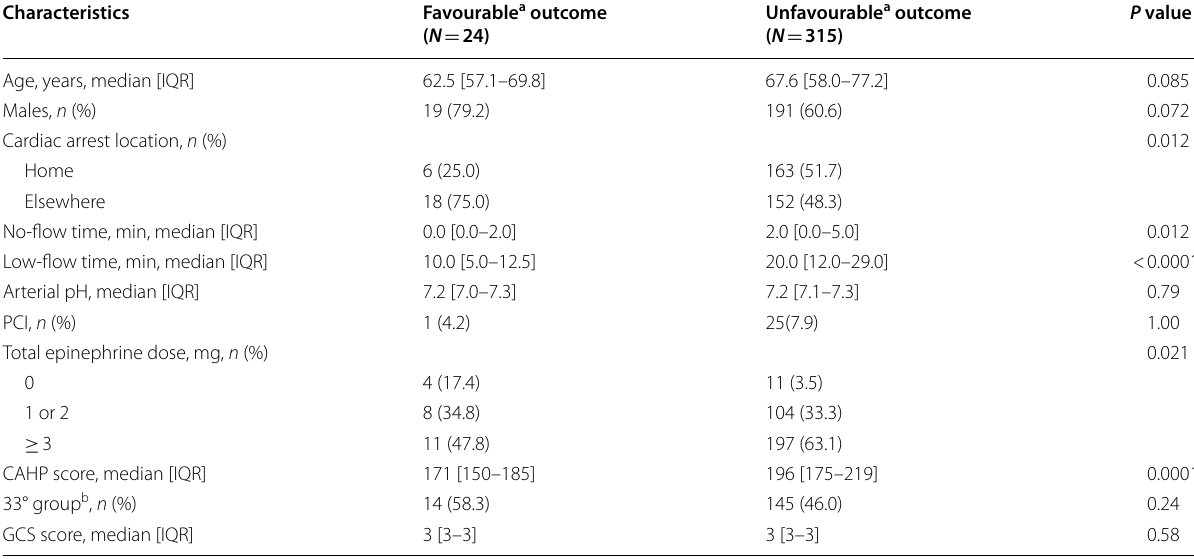
PCI: percutaneous coronary intervention; CAHP: Cardiac Arrest Hospital Prognosis; GCS: Glasgow Coma Scale a Favourable outcome was defined as a Cerebral Performance Category score of 1 or 2 on day 90 and unfavourable outcome as a Cerebral Performance Category score of 3, 4, or 5 on day 90 b In the HYPERION trial used as the source of data for the present study, patients were allocated at random to treatment with hypothermia at 33 °C or normothermia at 37 °C